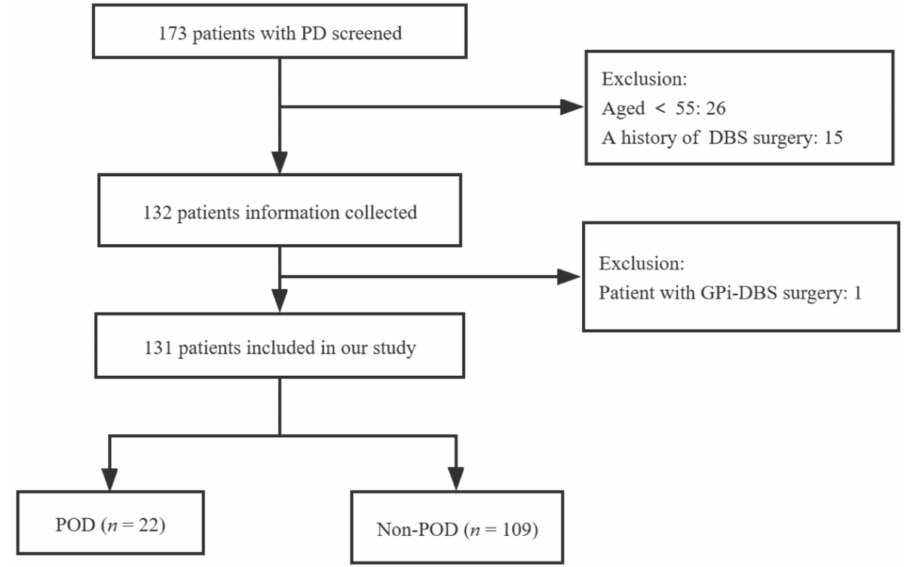
Figure 1. Flow chart of participants in the